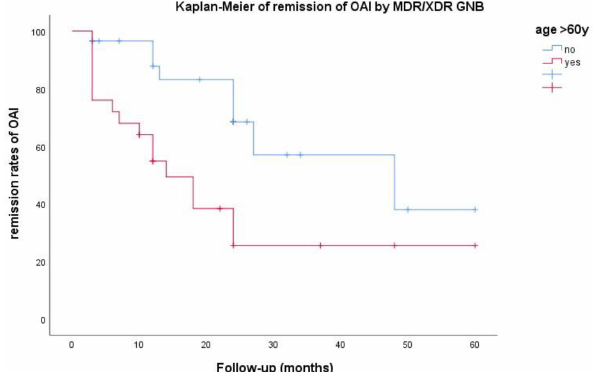
Figure 2. Kaplan–Meier survival plot of remission of OAI the lower limbs by MDR/XDR GNB (log rank x 2 = 7 . 919, DF = 1, p = 0 .